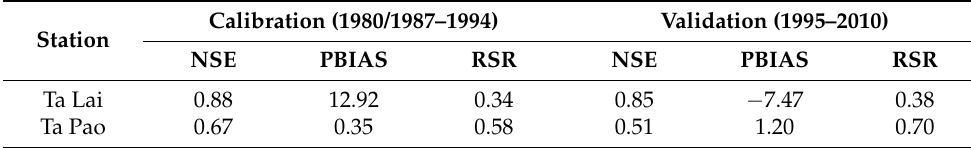
Figure 4. Comparison of simulation results and observated data at Ta Lai and Ta Pao stations. Table 4. Model performance for calibration and